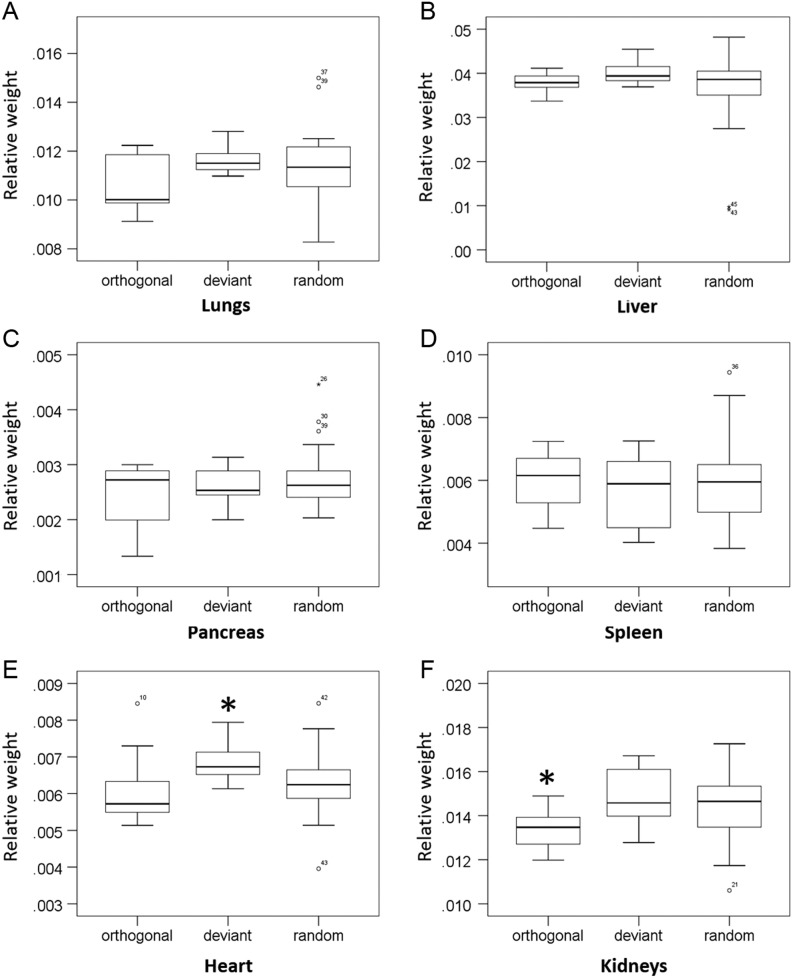
Boxplots comparing the relative organ weights from 2-week-old mice. (A) Lungs, (B) liver, (C) pancreas, (D) spleen, (E) heart and (F) kidneys. Relative organ weights were calculated by dividing the organ weight by the total body weight. A total of 45 pups were analysed: orthogonal (n = 12), deviant (n = 8) and random (n = 25). No significant difference was found among groups for lungs, liver, pancreas and spleen. Heart and kidneys relative weights showed difference among groups (P < 0.05 by Kruskal–Wallis test). *Denotes statistical difference (P < 0.05 by Mann–Whitney U test).